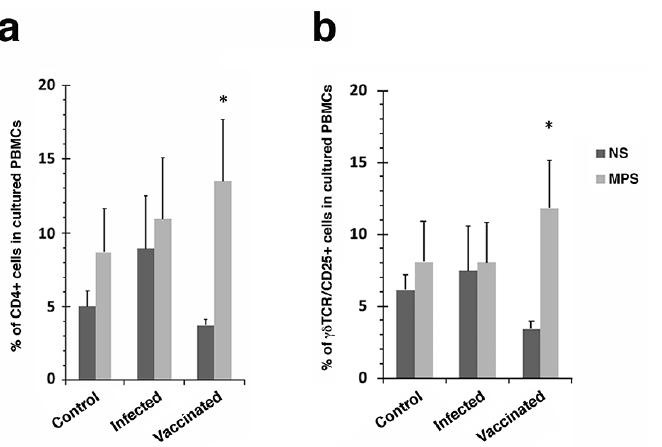
Figure 3. CD4+ and γδ -T cell proliferation of cultured PBMCs in response to Map antigen. The percentage of CD4+ ( a ) and γδ TCR/CD25+ cells ( b ) in cultured PBMCs are shown. Note the proliferation of each cell population after stimulation with MPS. Asterisk indicates a p value < 0.05. NS = no stimulation; MPS = stimulation with Map sonicate extract.